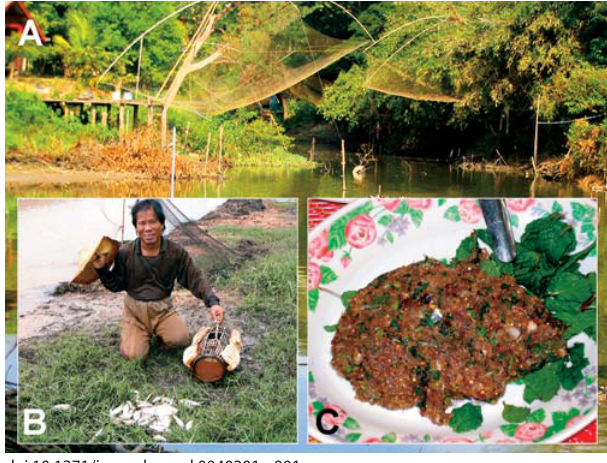
Figure 1. Preparation of a Meal of Koi-Pla Using Uncooked Cyprinoid Fishes (A) Fluke-infected fi sh are plentiful in the local rivers such as the Chi River in Khon Kaen province, Thailand. (B) Local people catch the fi sh in nets and prepare the fi sh-based meals with local herbs, spices, and condiments. (C) The fi nished dish of koi-pla accompanied by rice and vegetables. This dish is a dietary staple of many northeastern Thai villagers and is a common source of infection with O. viverrini